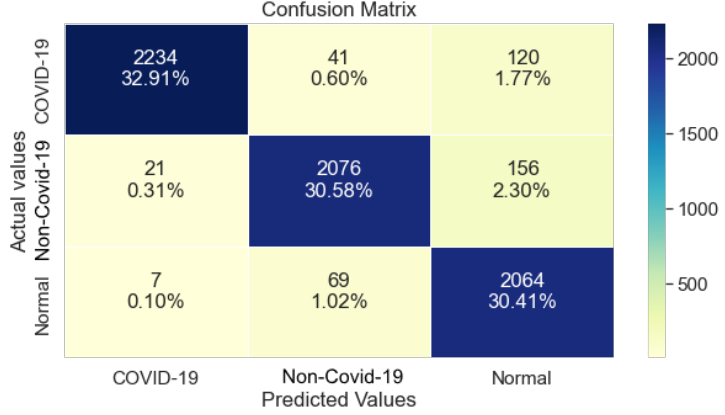
Figure 6. DenseNet169 Confusion matrix.